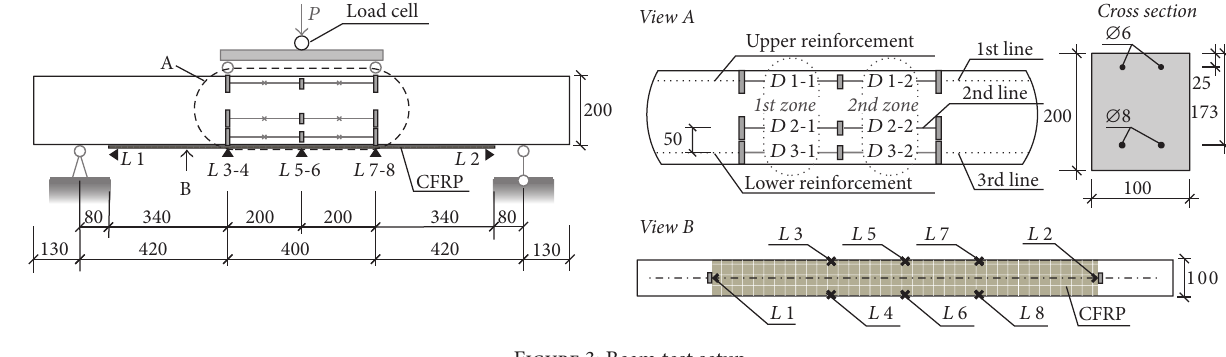
Figure 3: Beam test setup.